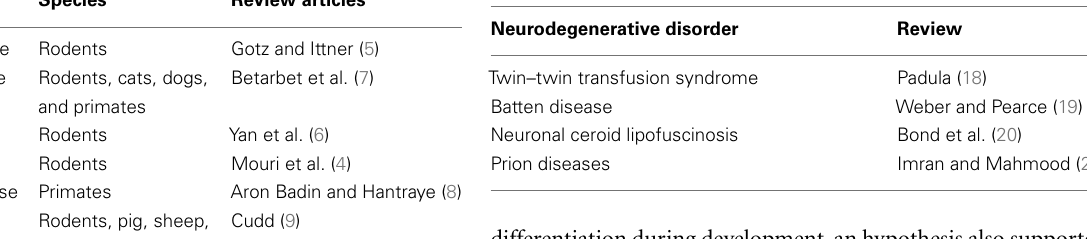
Table 1 |Animal models of human neurodegenerative disorders . Table 2 | Use of bovine tissues for the study of altered sexual differentiation and neurodegenerative research